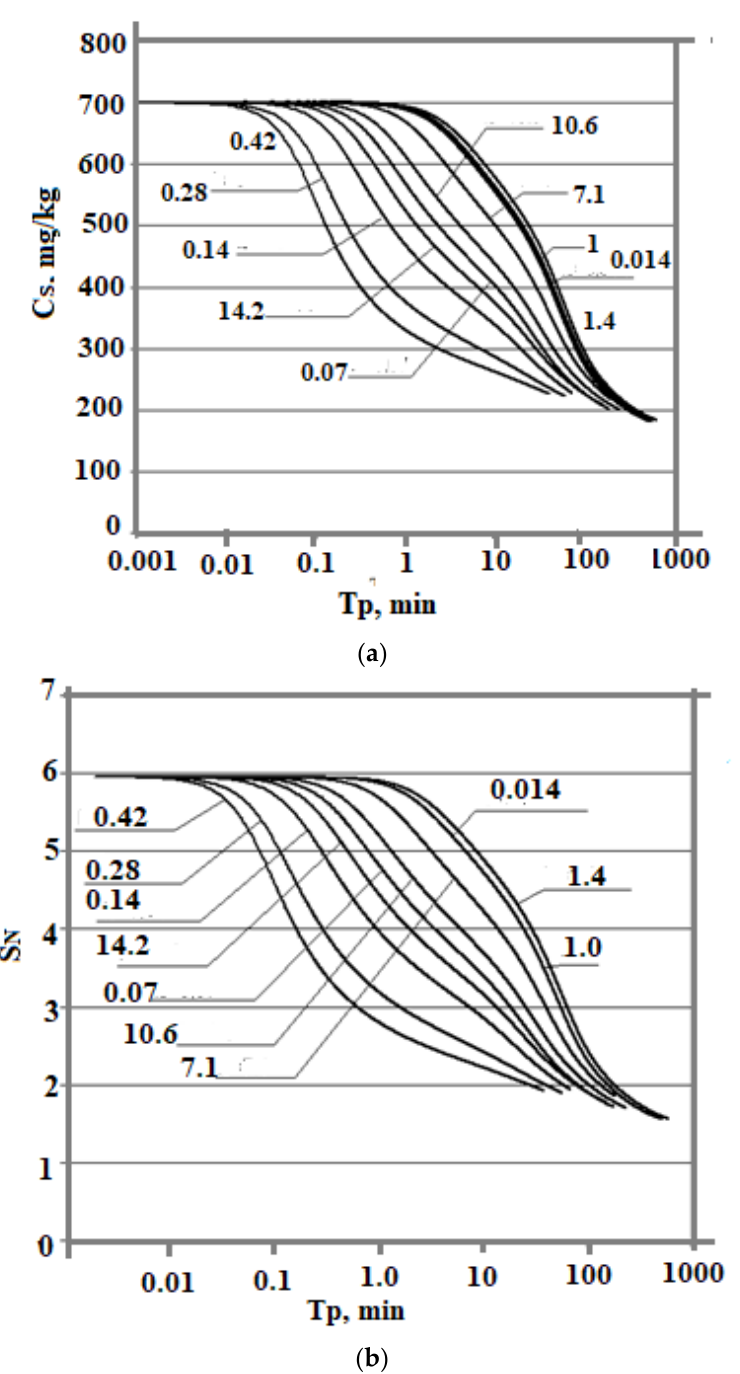
Figure 7. The dependence of the concentration of dissolved silicic acid ( a ) and supersaturation ( b ) on time. t = 20 °C, pH = 8.0, initial concentration C s = 700 mg/kg, and various values of ionic strength (mol/kg).